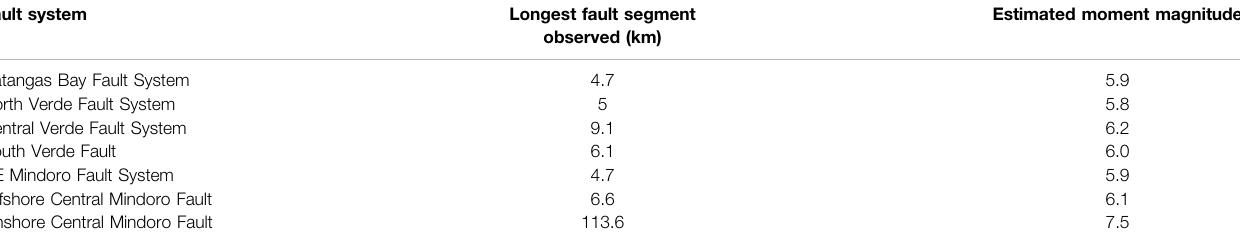
TABLE 1 | Probable magnitude from each fault system estimated from longest surface trace observed using fault-scaling relationship (Wells and Coppersmith, 1994).